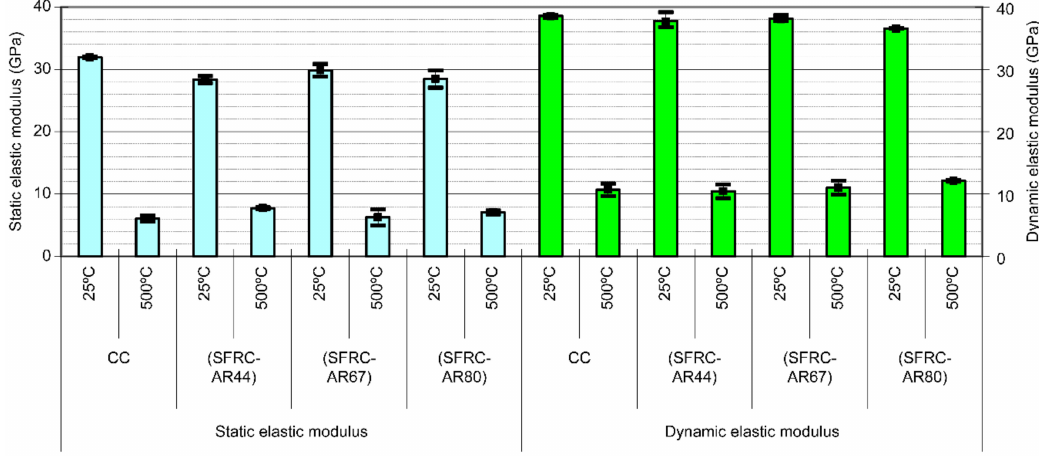
Figure 6. Static and dynamic elastic moduli of the non-fibrous and fiber-reinforced concrete specimens.